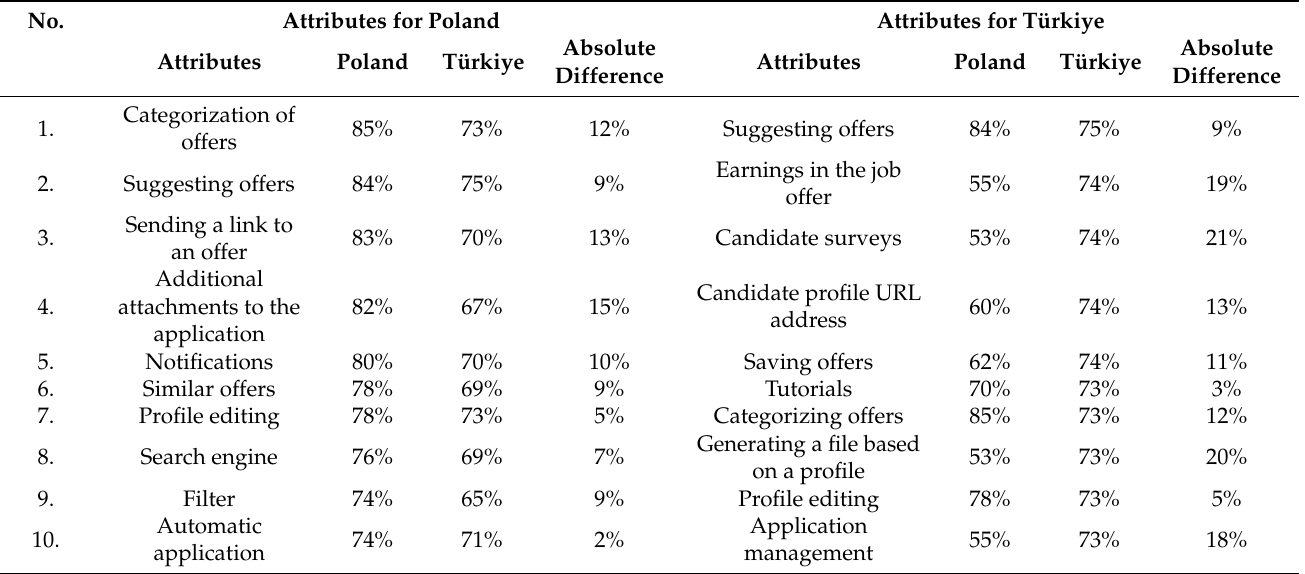
Table 4. Similarities and differences in the assessment of user requirements for the HR portal in Poland and Türkiye in